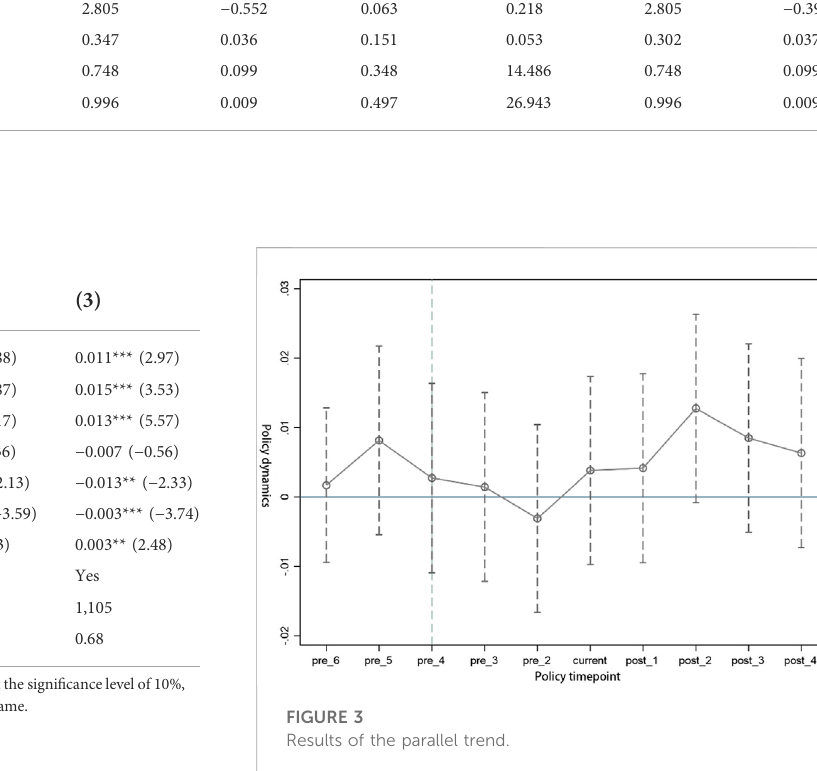
FIGURE 3 Results of the parallel